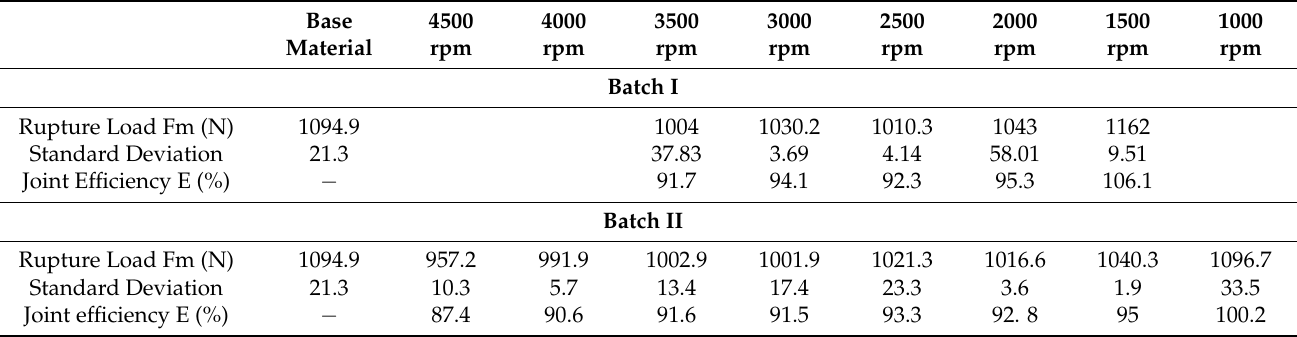
Table 4. Rupture loads (Fm) with standard deviations used in calculations and weld efficiency (Es) of the welds from the batch I and